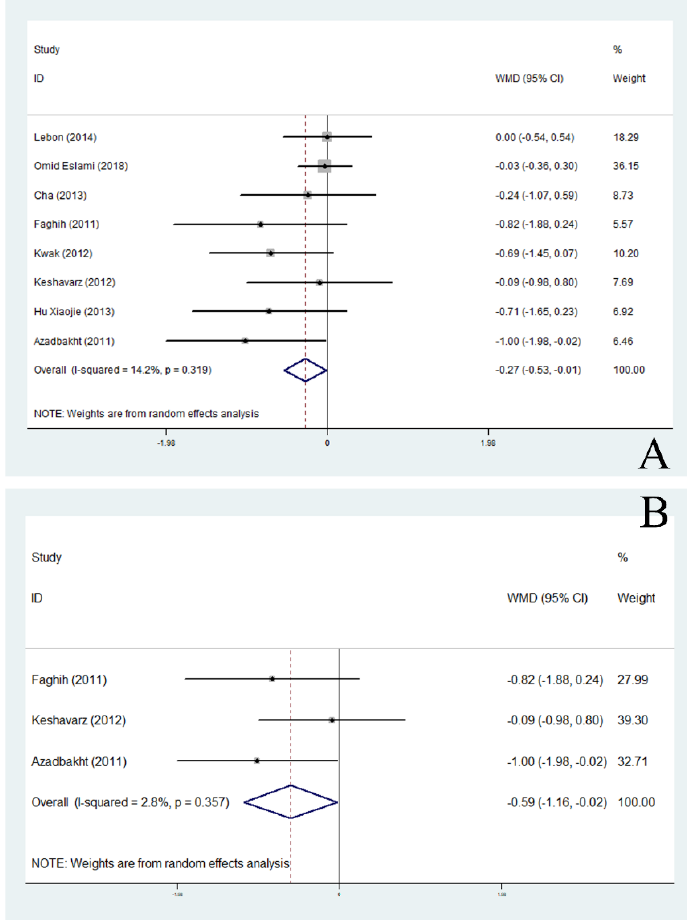
Figure 5. Meta-analysis of the effect of soy products on BMI in the Asian population ( A ) and non-menopausal women ( B ). ID: identification; WMD: weighted mean difference.